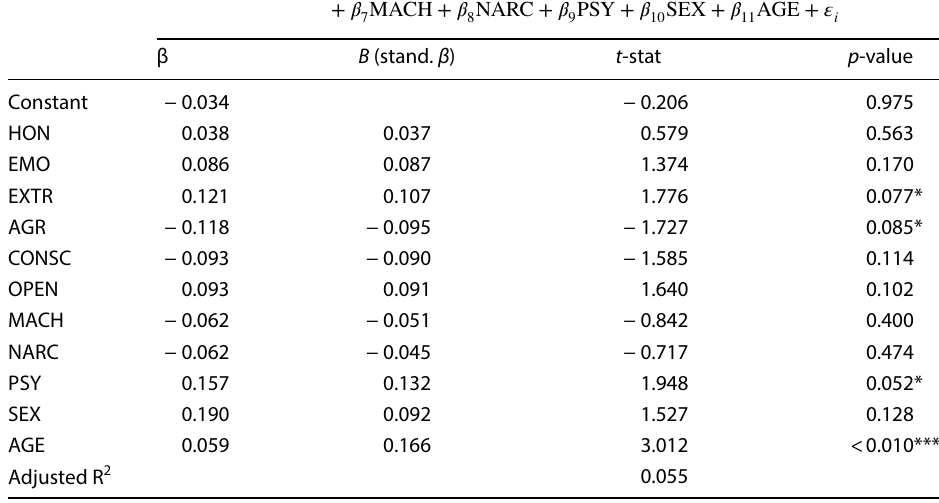
n = 348; Significant coefficients are indicated by *( p < 0.10), **( p < 0.05), and ***( p